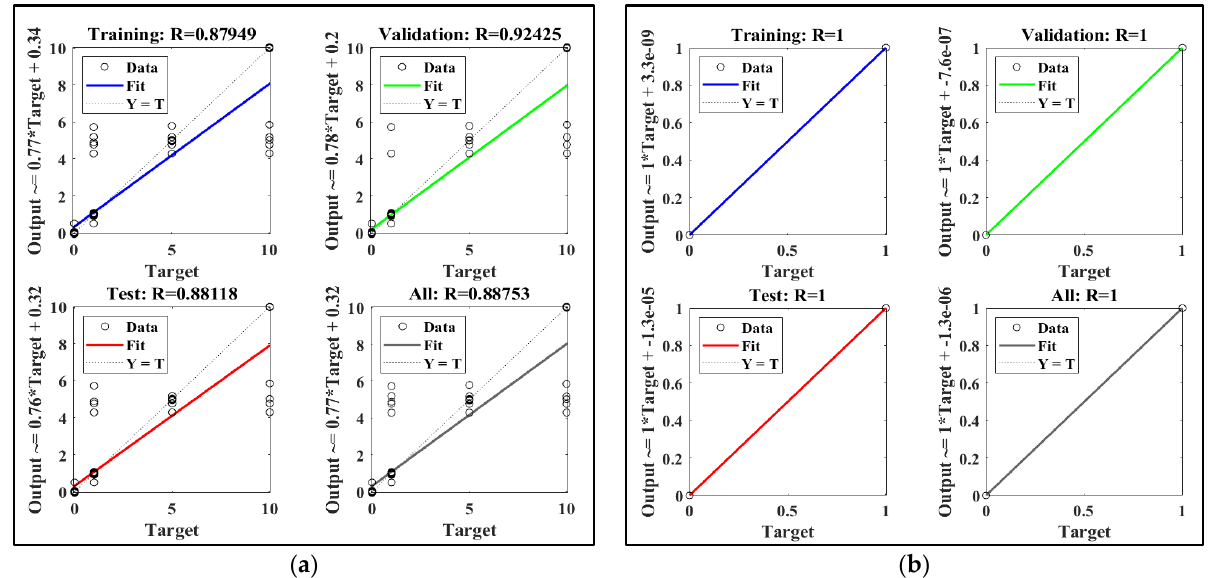
Figure 25. ANN regression graphs with training and test sets for ( a ) fault detection and classification, and ( b ) fault location.